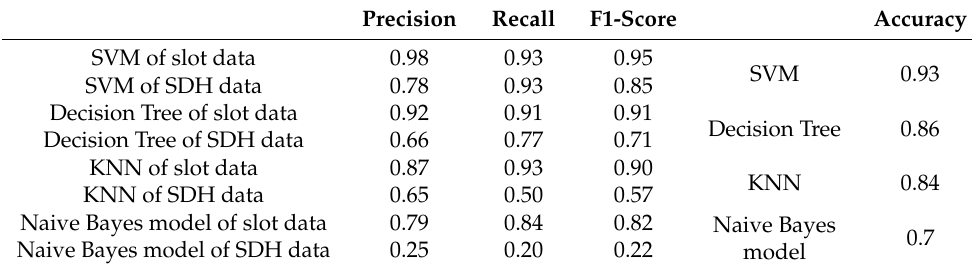
Table 4. Comparison of performance metrics of different methods. Precision Recall F1-Score Accuracy SVM of slot data 0.98